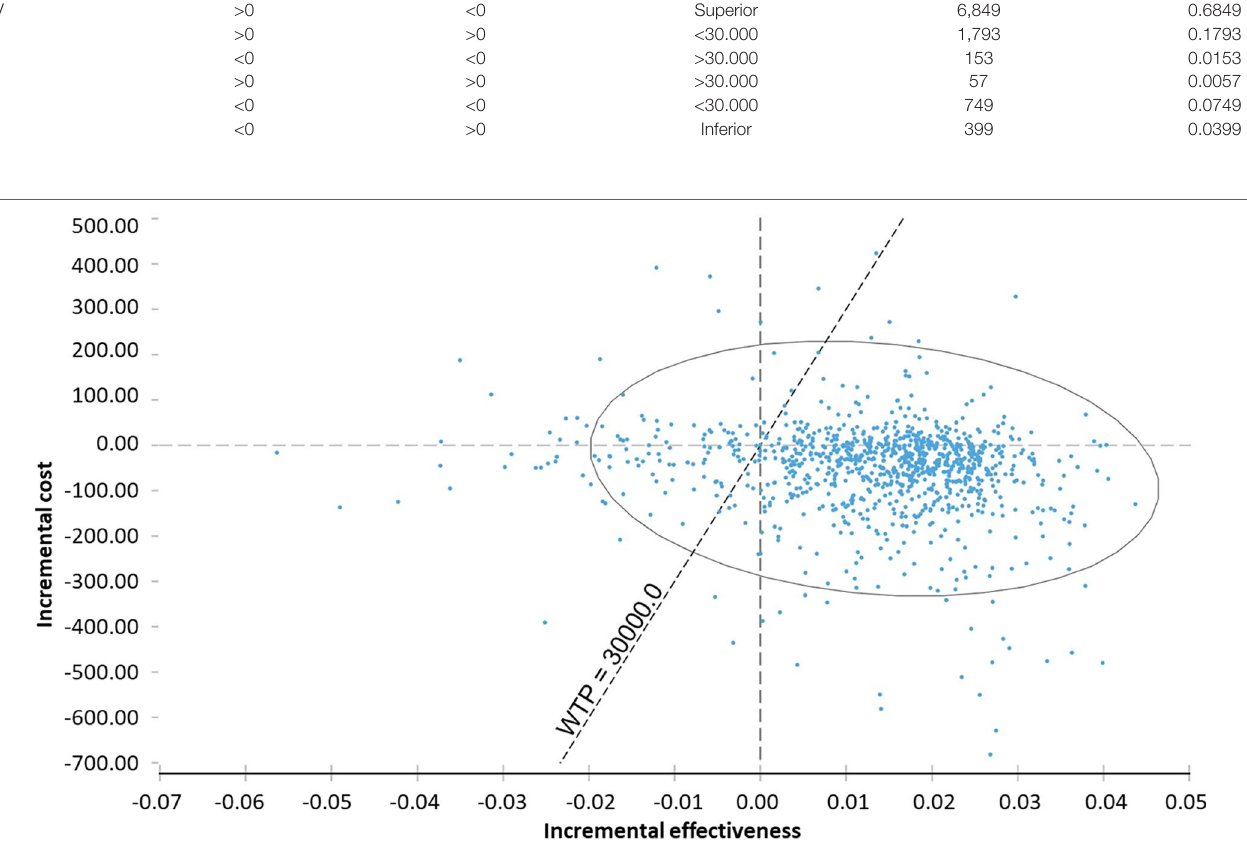
FIGURE 3 | Probabilistic sensitivity analysis of incremental cost-effectiveness ratio of chemoprophylaxis compared to no prophylaxis. WTP, willingness to